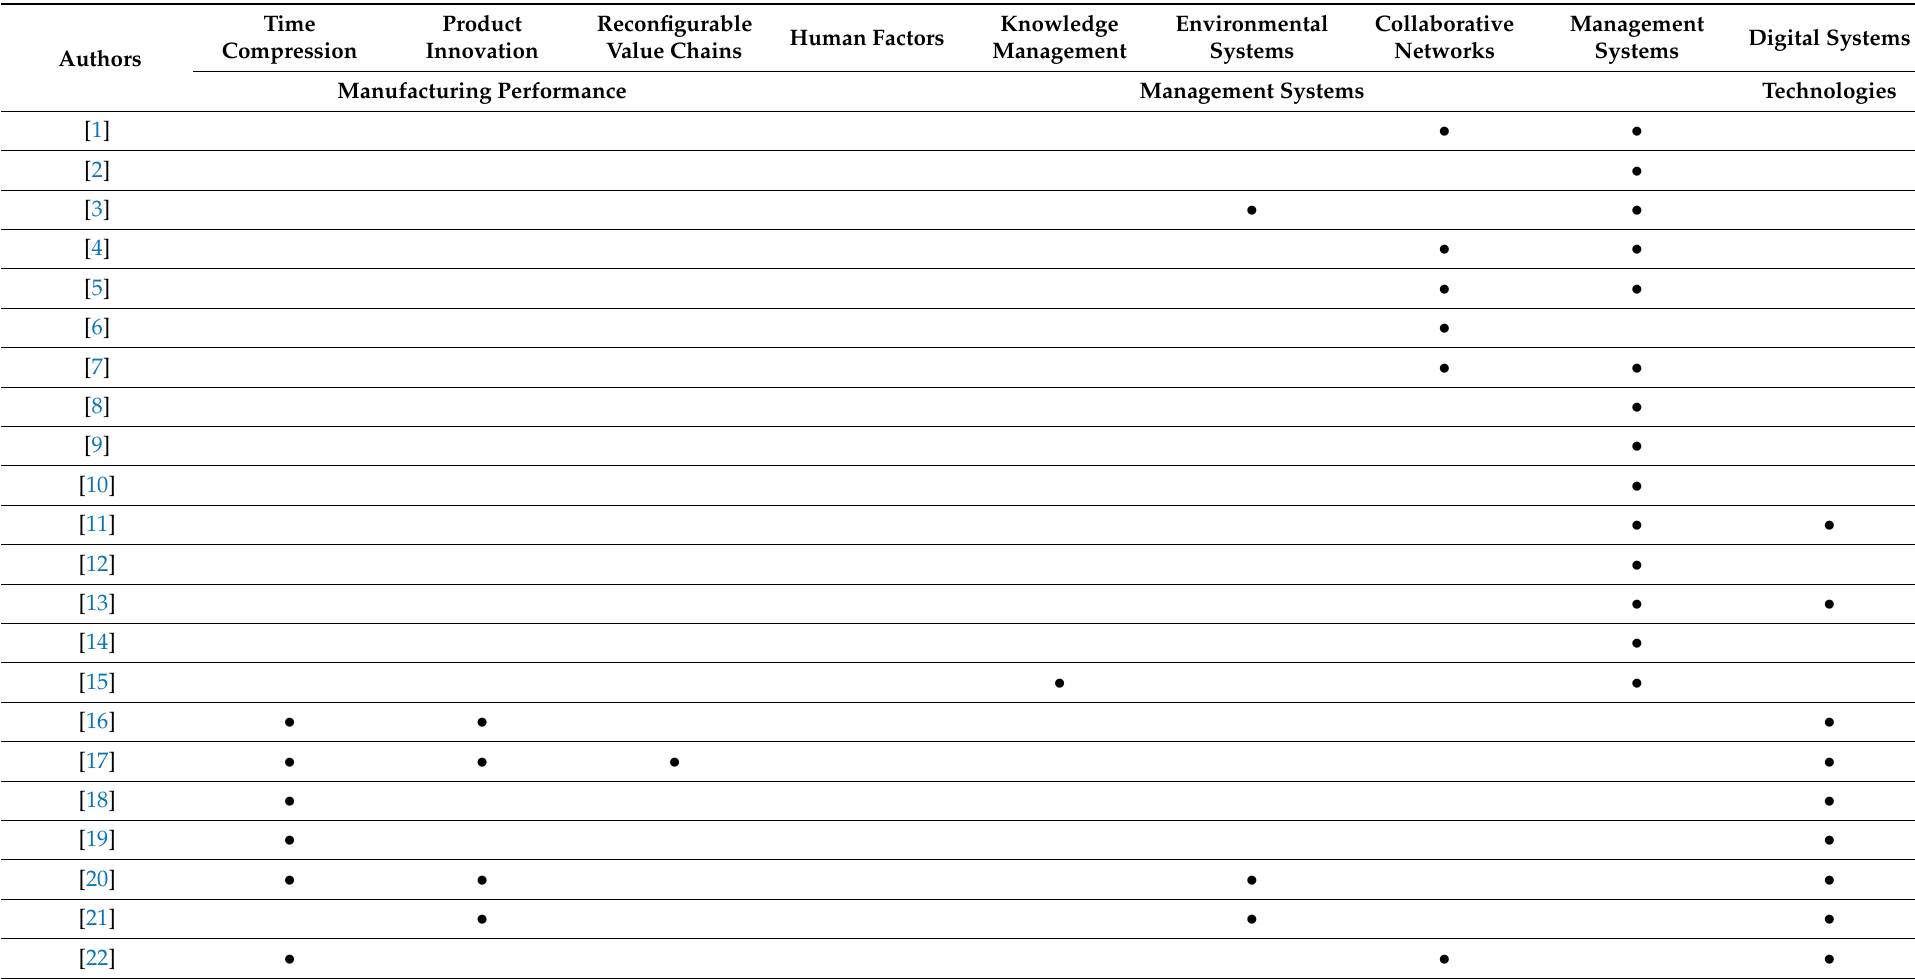
Table 2. Literature Analysis and Identification of SMS